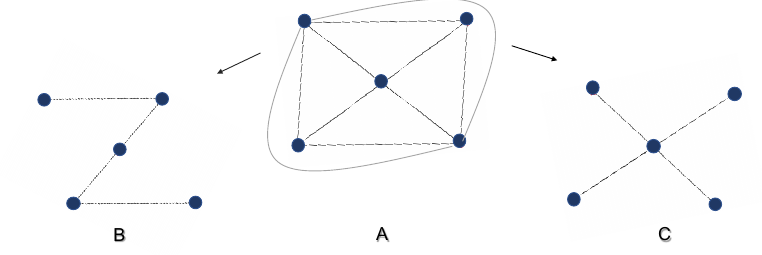
Figure 2. An example of two different spanning trees of K 5 (full graph with 5 nodes). Graph A is K 5, Graph B has only two leaves, and Graph C has the maximum leaf number (four leaves).